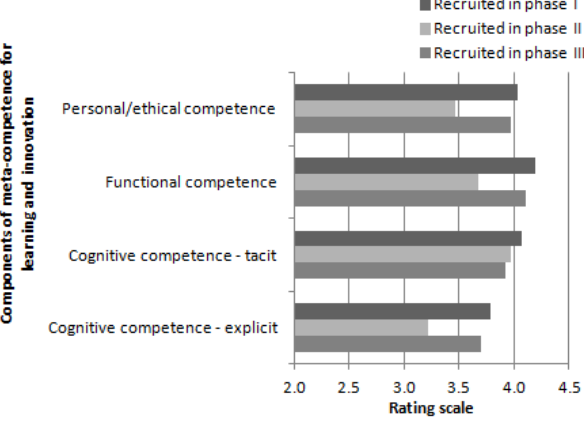
Fig. 11. Components of the meta-competence for continuous learn- ing and innovation perceived to be required in daily tasks, in phase I (1970–1987), II (1987–1998) and III (1998–present); rat- ing scale from 1 to 5, where 1=not at all, 3=to some extent, and 5=extensively.